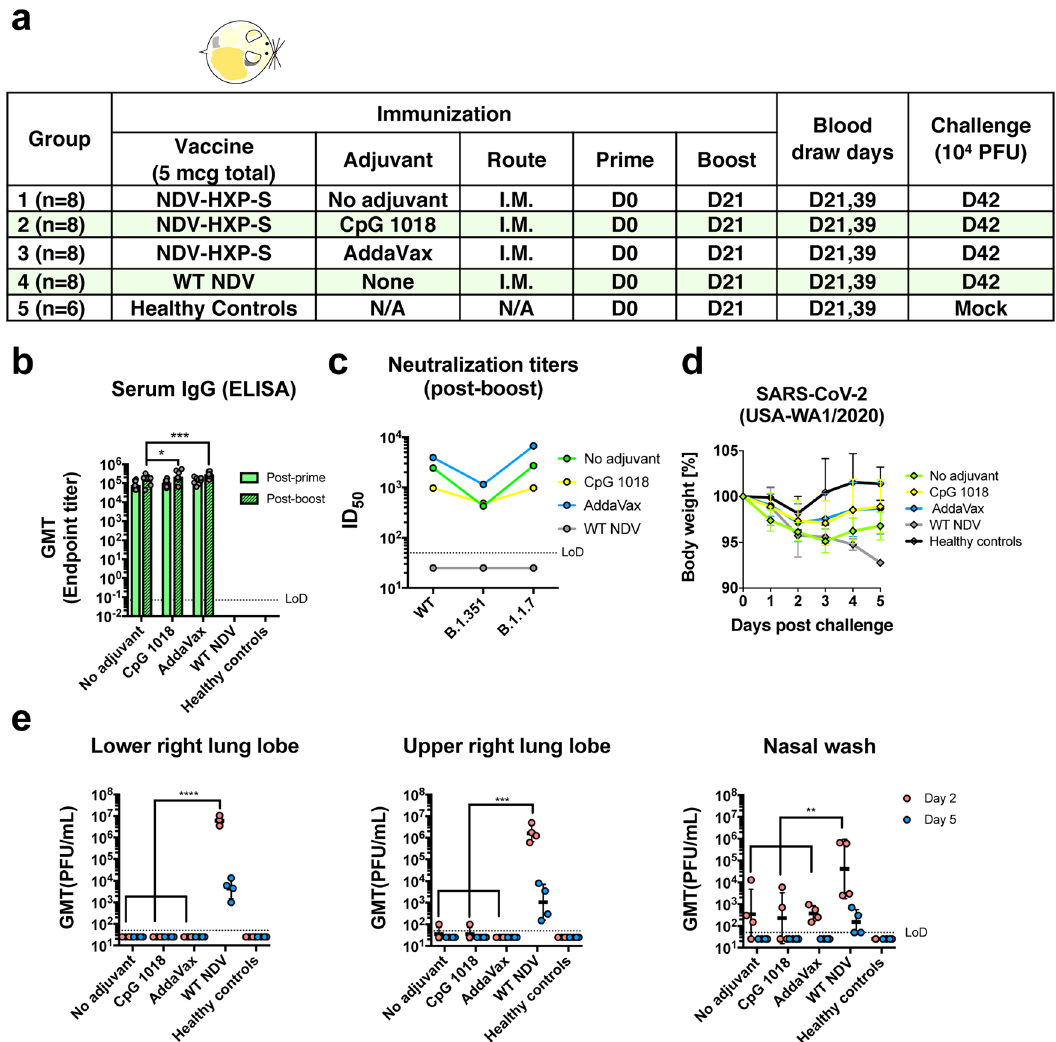
Fig. 3 Inactivated NDV-HXP-S induces protective antibody response in hamsters. a Design of the study. Eighteen-to-twenty-week-old female Golden Syrian hamsters were used. Groups 1 – 3 ( n = 8) were vaccinated with 5 µ g of NDV-HXP-S without adjuvants, with CpG 1018 and AddaVax, respectively. Group 4 ( n = 8) was vaccinated with 5 µ g of WT NDV as the negative control. Group 5 ( n = 6) was not vaccinated. The vaccine was administered via the intramuscular (I.M.) route at D0 and D21. Blood was collected at D21 and D39. Group 1 – 4 were challenged with 10 4 PFU of USA-WA1/2020 strain at D42. Group 5 was mock-challenged with PBS. b Spike-speci fi c serum IgG. Antibodies in post-prime (D21) and post-boost (D39) sera were measured by ELISAs. GMT endpoint titer was graphed. The error bars represent geometric SD. Statistical difference was analyzed by two-way ANOVA corrected for Dunnett ’ s multiple comparisons test (* p = 0.0262; *** p = 0.0006). c Neutralizing activity of serum antibodies. Post-boost sera from groups 1 – 4 were pooled within each group and tested in neutralization assays against USA-WA/2020 strain (WT), B.1.351 variant, and B 1.1.7 variant in technical duplicate (green: no adjuvant; yellow: adjuvanted with CpG 1018; blue: adjuvanted with AddaVax; gray: WT NDV control). Serum dilutions inhibiting 50% of the infection (ID 50 ) were plotted. (LoD = 1:50; an ID 50 = 1:25 was assigned to negative samples) d Body weight change of hamsters. Body weights were recorded for 5 days after challenge (green: no adjuvant; yellow: adjuvanted with CpG 1018; blue: adjuvanted with AddaVax; gray: WT NDV control; black: healthy controls). The error bars represent geometric SD. e Viral load in the lungs and nasal washes. The lower right and upper right lung lobes of a subset of animals ( n = 4 for groups 1 – 4; n = 3 for group 5) from each group were collected at day 2 (red) and day 5 (blue) post challenge. Each lung lobe was homogenized in 1 mL PBS. Nasal washes were collected in 0.4 mL of PBS. Viral titers were measured by plaque assay on Vero E6 cells and plotted as GMT of PFU/mL (LoD = 50 PFU/mL; a titer of 25 PFU/mL was assigned to negative samples). The error bars represent geometric SD. Statistical difference was analyzed by two-way ANOVA corrected for Dunnett ’ s multiple comparisons test (** p = 0.0026 (WT NDV vs. no adjuvant), p = 0.0025 (WT NDV vs. CpG 1018), p = 0.0024 (WT NDV vs. AddaVax); *** p = 0.0001; **** p < enhanced NAb titers (ID 50 = 3913 to the WT; ID 50 = 6684 to the approximately fourfold reduction of neutralizing activity to the B.1.1.7 variant), but the CpG 1018 did not (ID 50 = 970 to the WT; B.1.351 (ID 50 = 1144) was observed in the AddaVax group ID 50 = 973 to the B.1.1.7 variant). Interestingly, the antibodies in (Fig. 3c). After the challenge, animals in both adjuvanted groups the CpG 1018 group appeared to be more cross-neutralizing to showed quicker recovery of the body weight than animals in the B.1.351 with only a twofold decrease (ID 50 = 480). An approxi- unadjuvanted group (Fig. 3d). Viruses were cleared in the lungs of mately sixfold reduction of neutralizing titer to the B.1.351 all NDV-HXP-S vaccinated hamsters at day 2 except for one out (ID 50 = 425) was observed in the unadjuvanted group, whereas of four animals in the unadjuvanted and CpG 1018 group, which